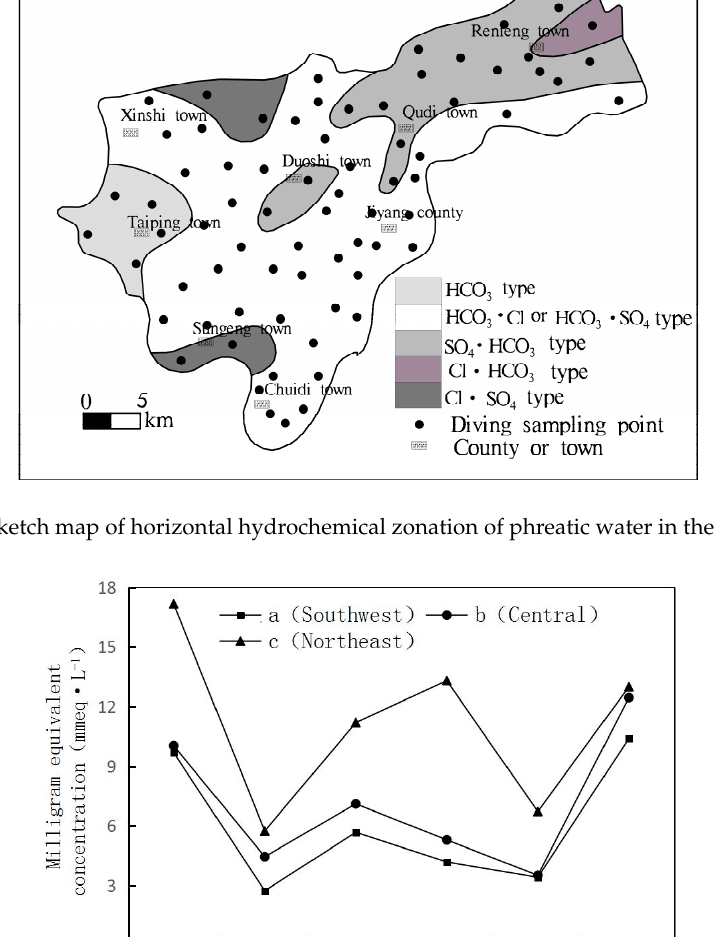
Figure 4. Variation trend of the shallow groundwater Figure 3. Variation trend of the shallow groundwater component.